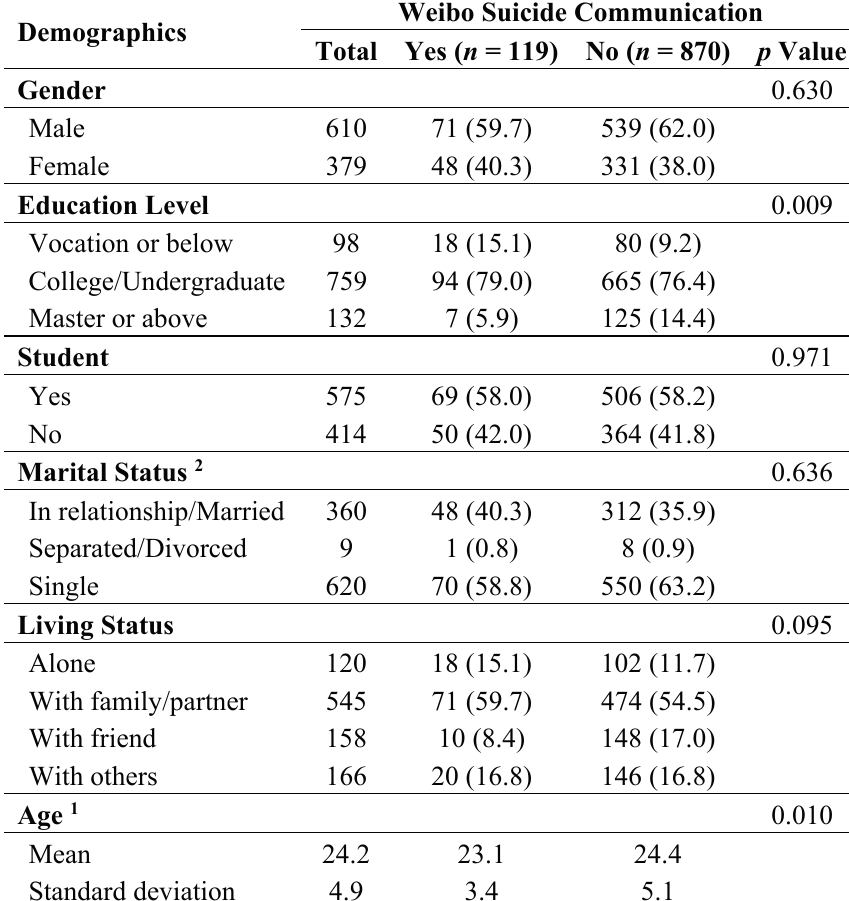
Table 1. Summary of demographic characteristics (% of column total) and statistical tests between